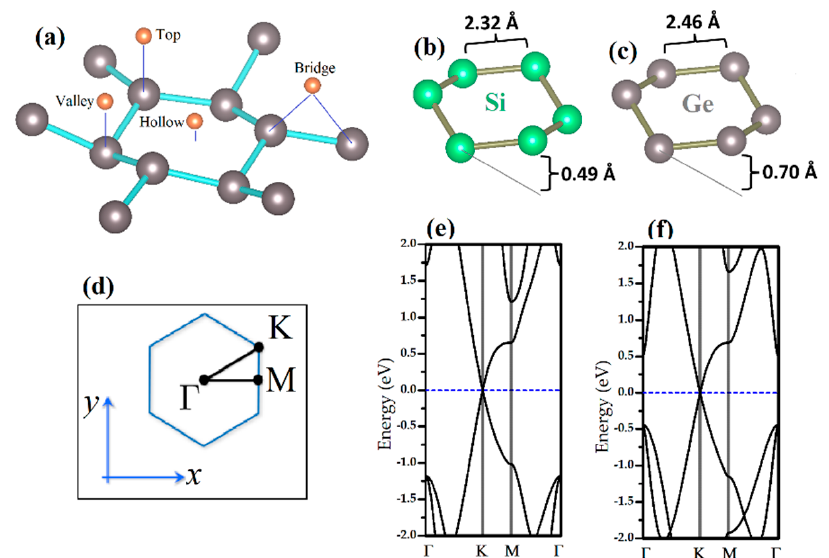
Figure 1. ( a ) Favorable adsorption sites: hollow, top, bridge, and valley for silicene and germanene. Buckled structure of ( b ) silicene and ( c ) germanene. Buckling and Si-Si and Ge-Ge distances are presented. ( d ) High-symmetry points of silicene and germanene. Band structure of bare ( e ) silicene and ( f ) germanene.